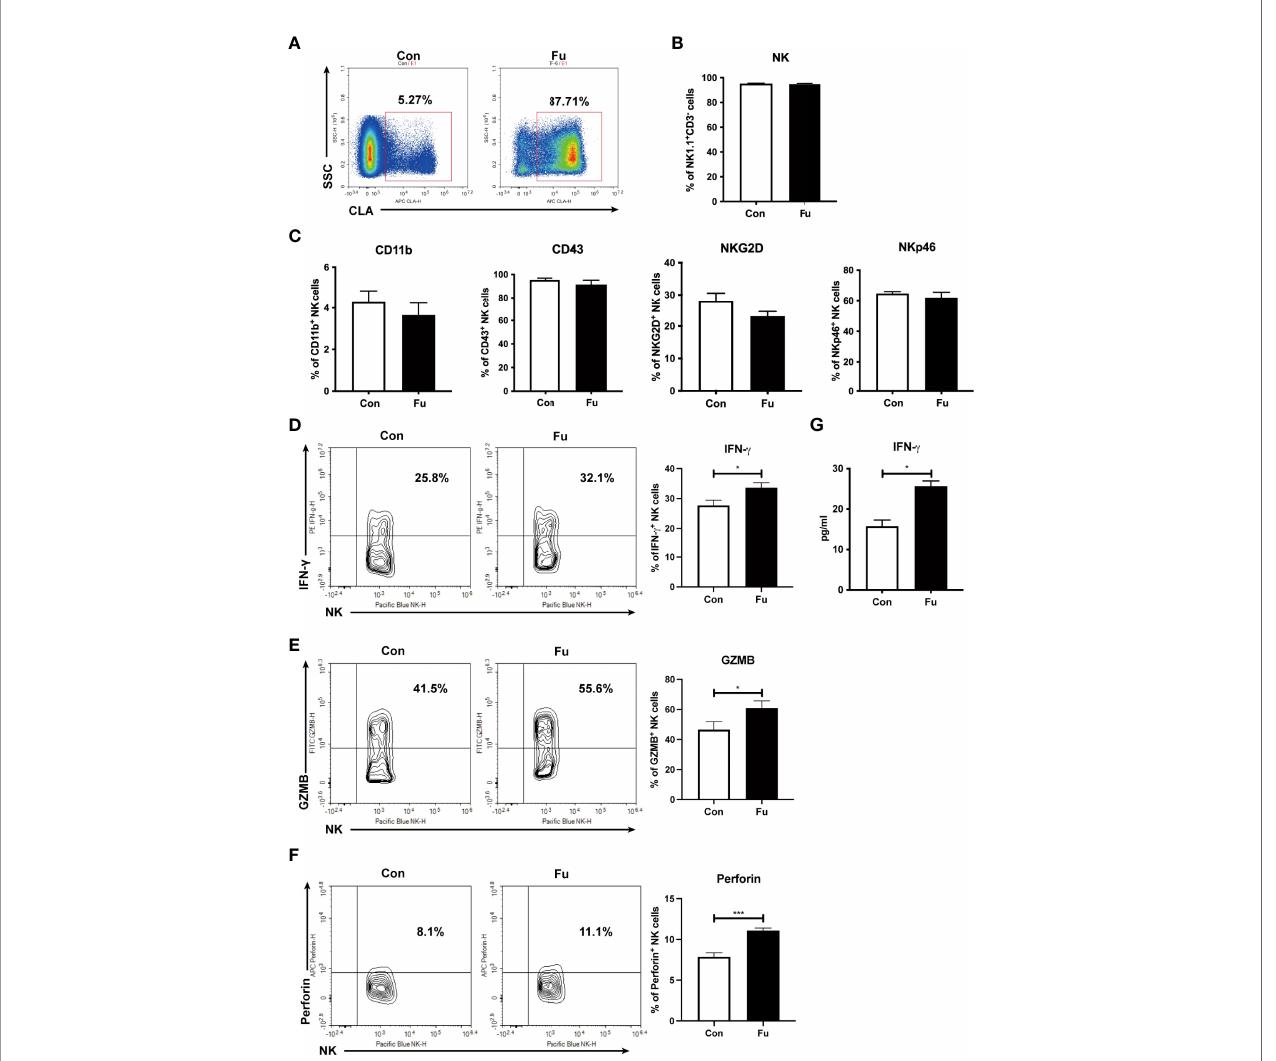
FIGURE 3 | Ex vivo fucosylation augmented cytotoxic activities of NK cells. (A) Representative fl ow cytometry plots of control and fucosylated BM progenitor cells. (B) The percentage of NK1.1 + CD3 - cells in the generated control and fucosylated NK cells. (C) Expressions of CD11b, CD43, NKG2D, NKp46 in control and fucosylated NK cells are shown. (D, F , G) Representative fl ow cytometry plots and statistics of the proportions of IFN- g , GZMB and perforin productions in control and fucosylated NK cells are shown, respectively. (E) IFN- g production in the superannuants of control and fucosylated NK cells were detected by ELISA (n = 4 per group). Data are representative of three independent experiments and shown as mean ± SD. * p < 0.05; *** p <